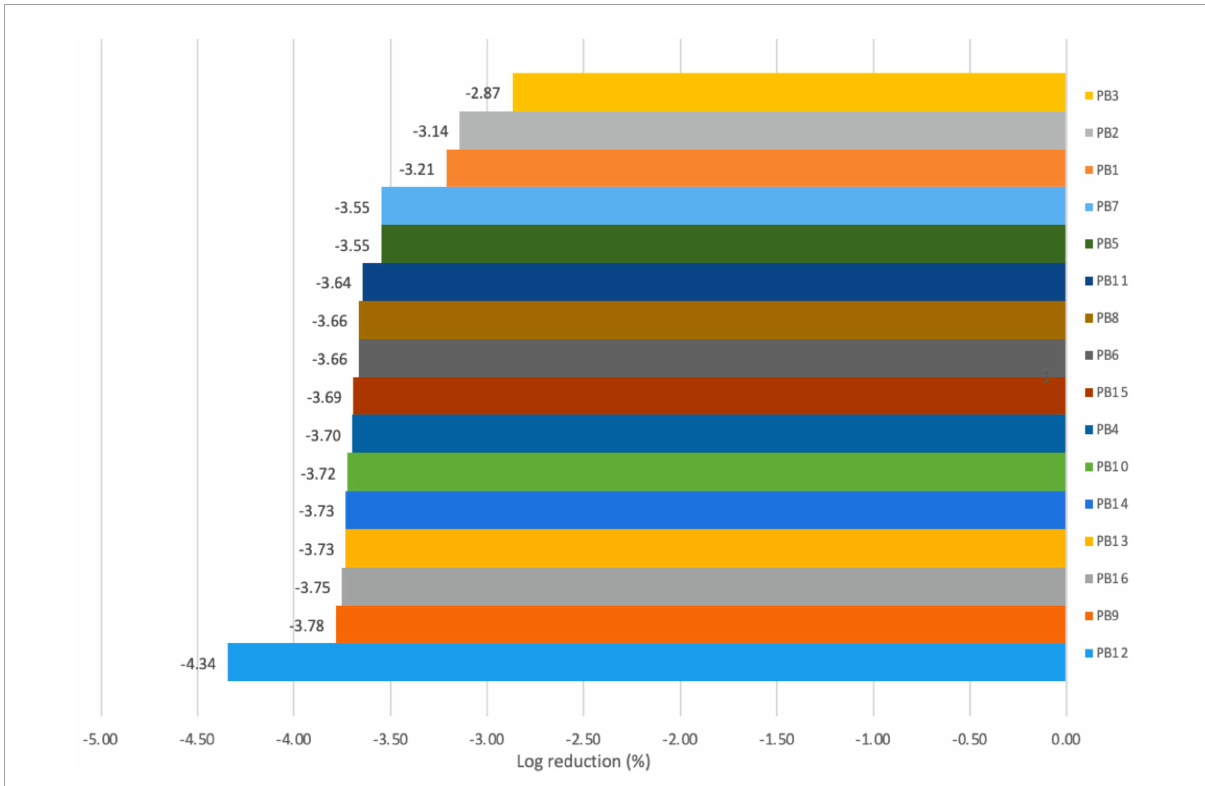
FIGURE3 Log reduction (%) in the cell counts in PBs at the end of storage (day 21) obtained with fermentation step. Legend: PB1–PB4: (CSMF1–CSMF4) + UTNGt2; PB5–PB8: (CSMF1–CSMF4) + UTNGt5; PB9–PB12: (CSMF1–CSMF4) + L.Lac; PB13–PB16: (CSMF1–CSMF4) + L.r. CSMF1: semi-skimmed milk + 1% cocoa + 2% glucose; CSMF2: semi-skimmed milk + 2% cocoa + 2% glucose; CSMF3: semi-skimmed milk + 3% cocoa + 2% glucose; CSMF4: semi-skimmed milk + 2%